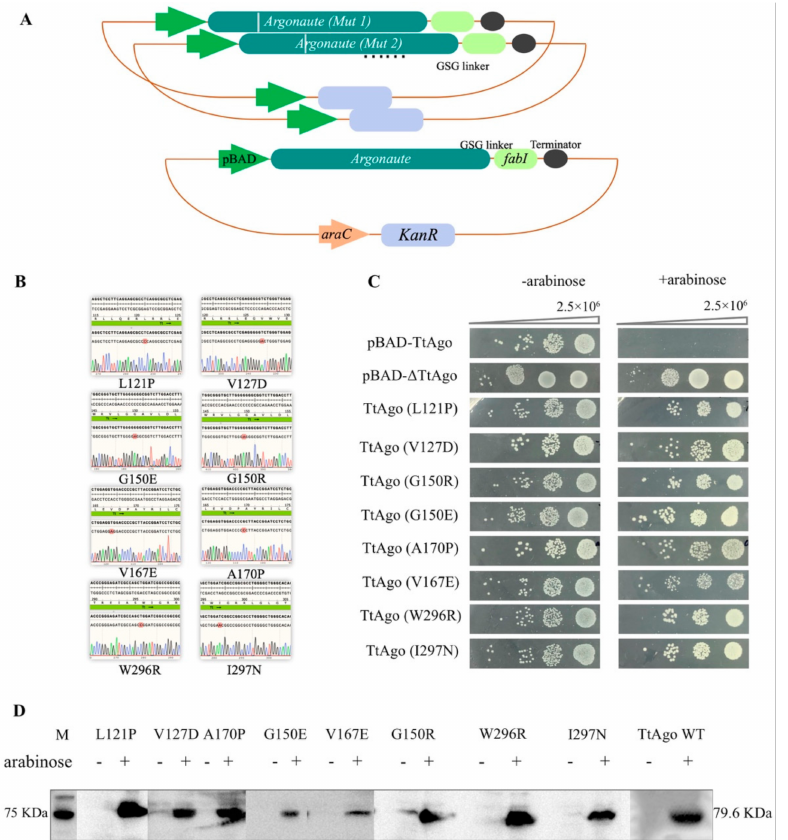
Figure 9. Function analysis of eight isolated loss-of-function TtAgo single point mutations in BL21(DE3). ( A ) Schematic diagram of the construction of random mutant library in pET28a-pBAD- TtAgo-fabI vector. Mutations introduced by error-prone PCR (EP-PCR) are indicated as grey bars in the TtAgo coding region. ( B ) Sequencing results from the eight isolated TtAgo loss-of-function mutants. Mutated nucleotide is shown in red. ( C ) Colony spot plating assay for pET28a-pBAD- TtAgo, pET28a-pBAD- ∆ TtAgo, and eight isolated TtAgo loss-of-function mutant, with and without L-arabinose induction. The pET28a-pBAD-TtAgo represents intact TtAgo enzyme activity, and pET28a-pBAD- ∆ TtAgo represents enzymatic dead TtAgo activity. Three biological replicates were performed for each group. “-arabinose” represents without arabinose induction, “+arabinose” rep- resents with arabinose induction. ( D ) Protein expression examination by Western blotting. The E. coli BL21 (DE3) competent cells were transformed with each of the eight re-constructed pET28a- pBAD-mTtAgo plasmids, and pET28a-pBAD-TtAgo plasmid. Protein expression was induced with L-arabinose (10 mM) for 4 h when OD 600 reached approximately 0.5. Total protein was extracted for Western blotting with His-Tag Mouse Monoclonal